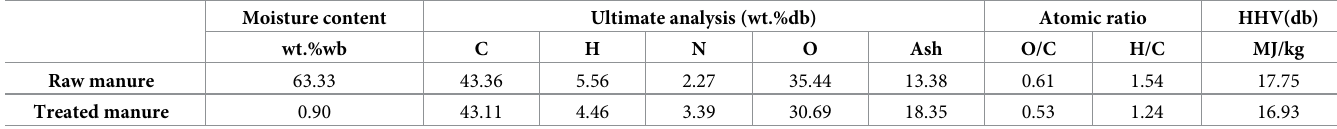
Table 1. Physicochemical properties of the raw manure and manure treated at 90 ˚C (wb: Wet basis; db: Dry basis). Moisture